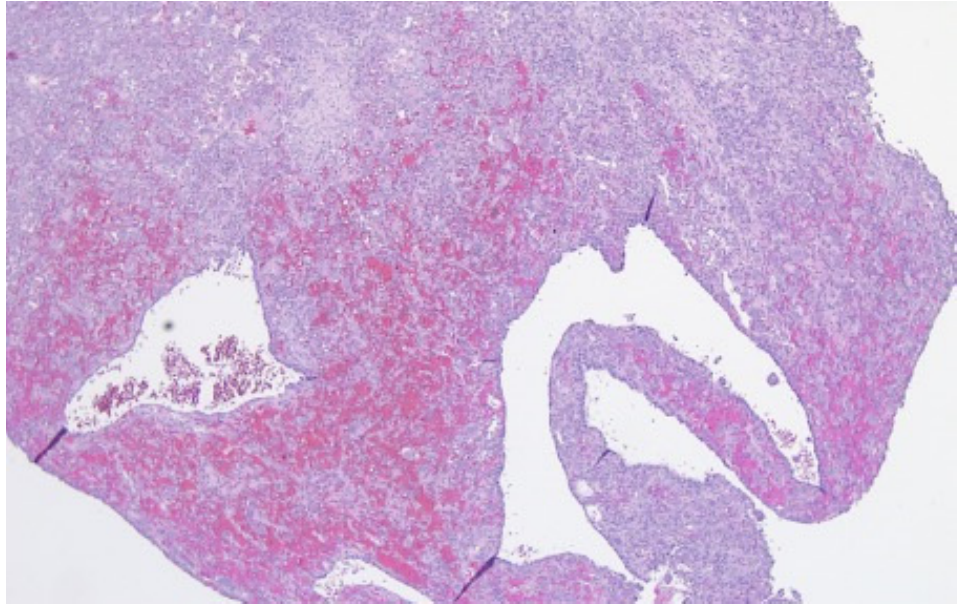
Figure 1. Cystic elements of an